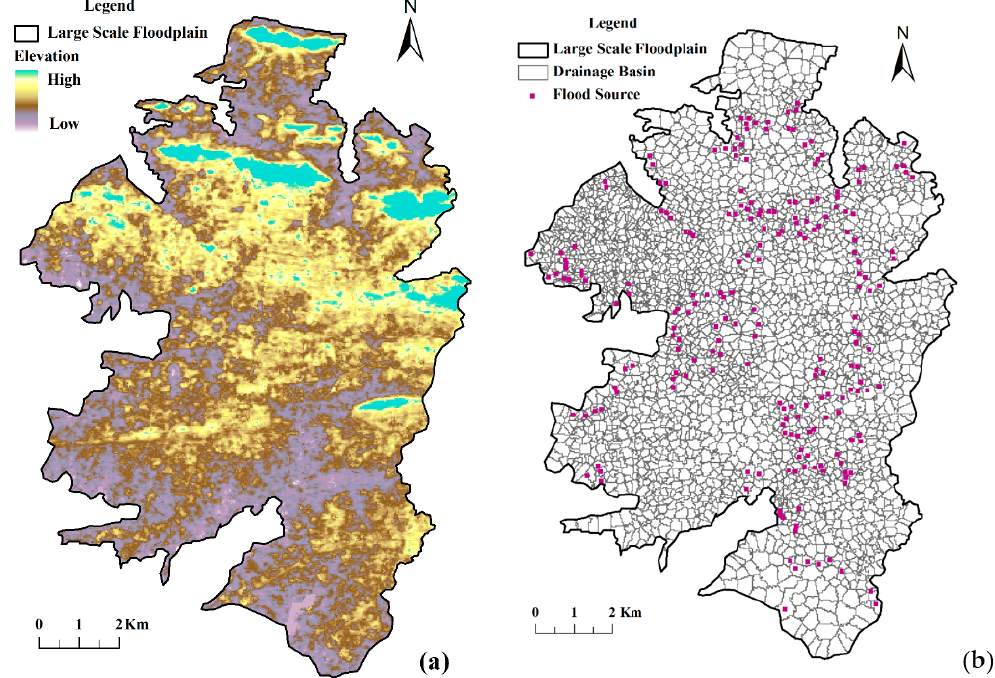
Figure 10. ( a ) Study area of a large ‐ scale floodplain in the city of Wuhan; and ( b ) distribution of drainage basins and flood sources in the large ‐ scale